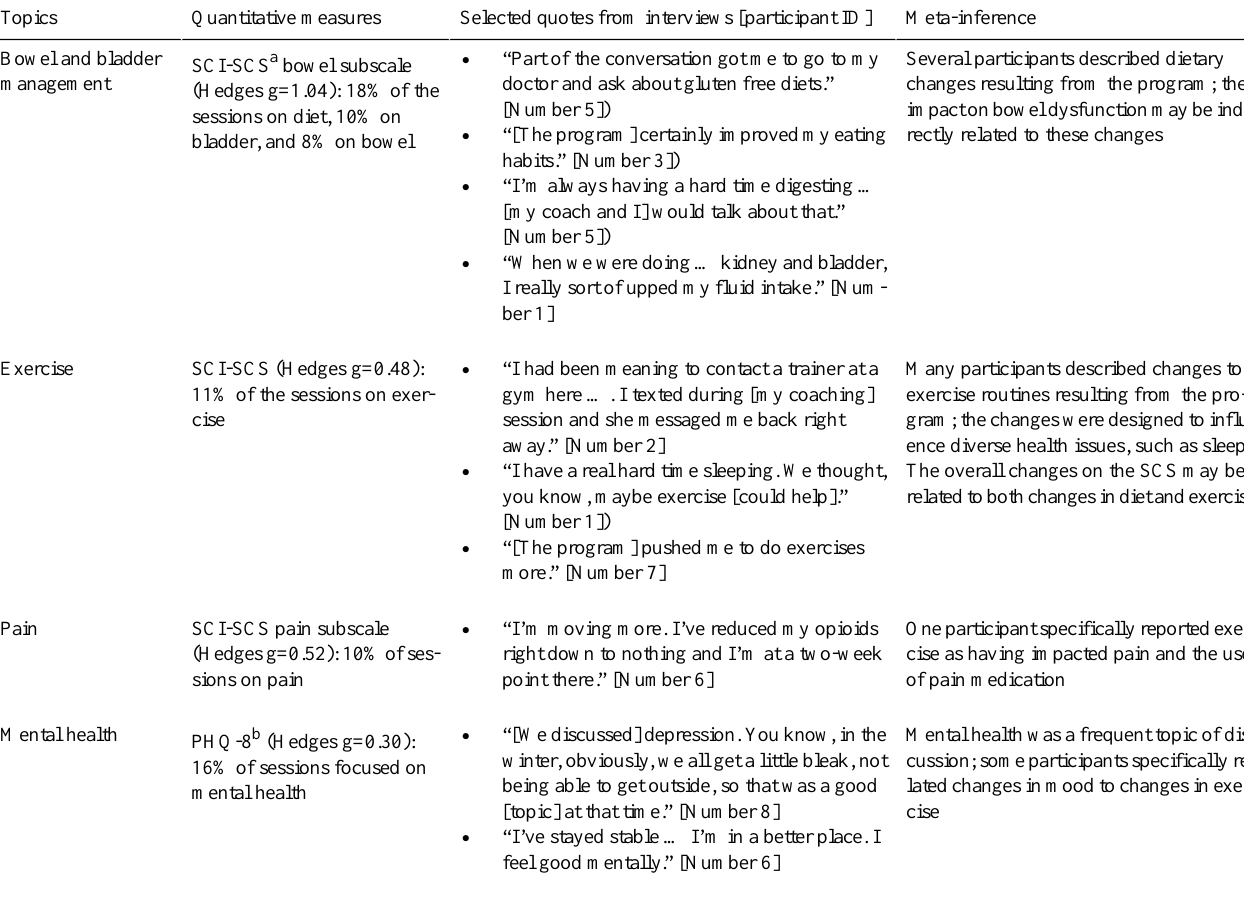
Table 4. Joint display of impact statements made by participants alongside quantitative